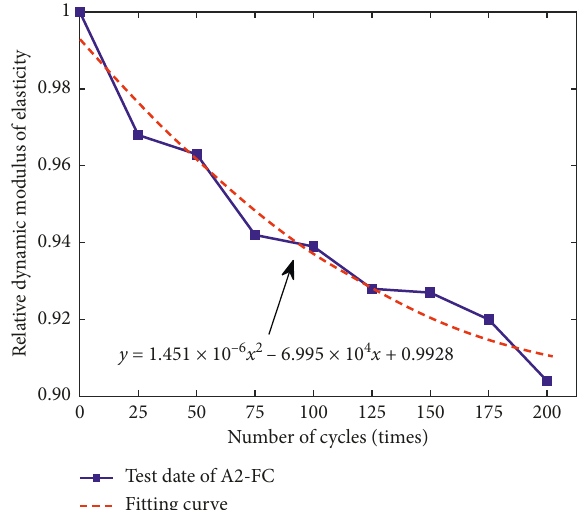
Figure 8: Simulation of the evolution equation for concrete relative dynamic modulus of elasticity under alternating freeze-thaw attacks and